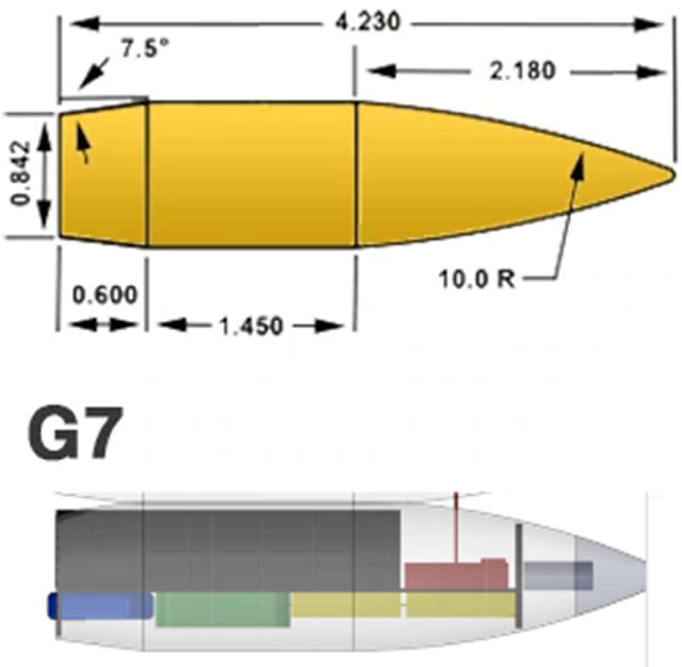
Figure 2. G7 bullet shape (top) and drop test capsule shape. Documented experimental data for the drag coefficient of this shape were used and compared with our own calculations and simulations (Figure 3).